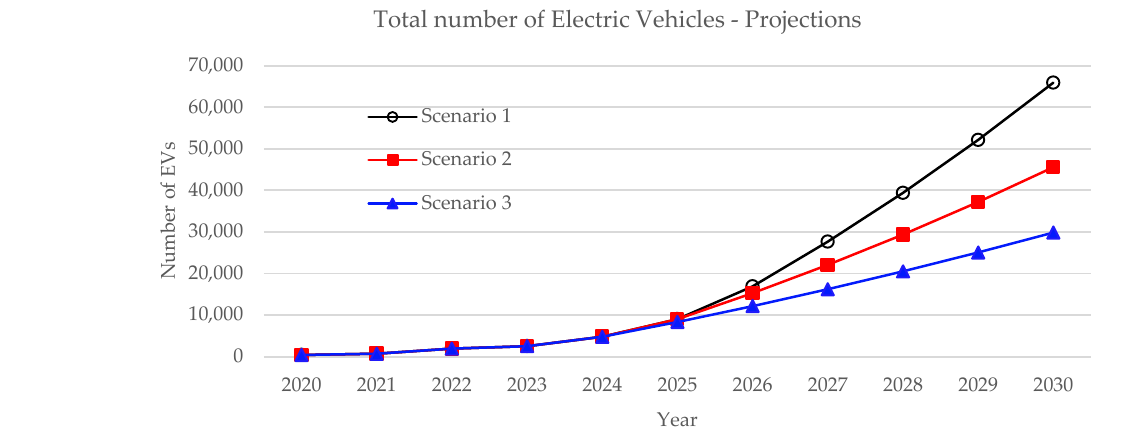
Figure 8. Electric vehicle fleet projections in Campinas, Brazil.